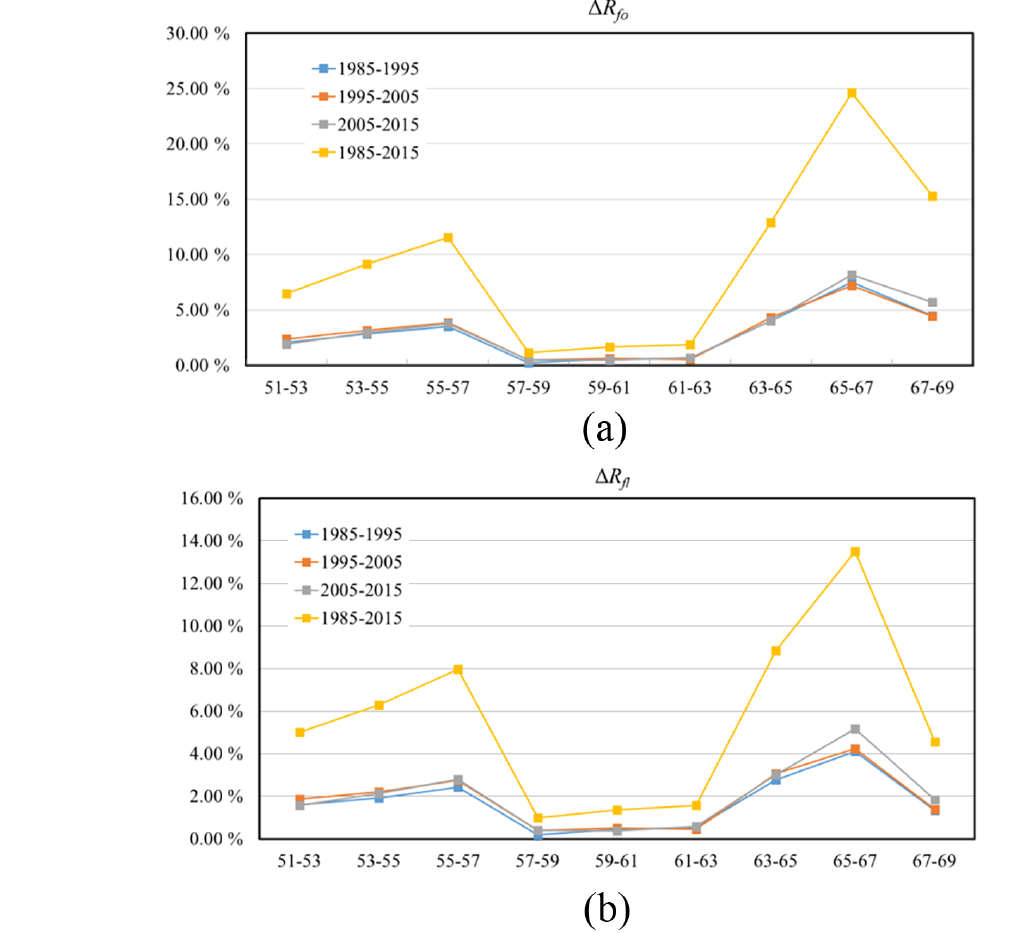
Figure 5. Forest coverage changes in different latitude zones during different time intervals as measured by (a) (cid:49)R fo and (b) (cid:49)R fl . Table 3. Quantitative details of the coverage of different forest